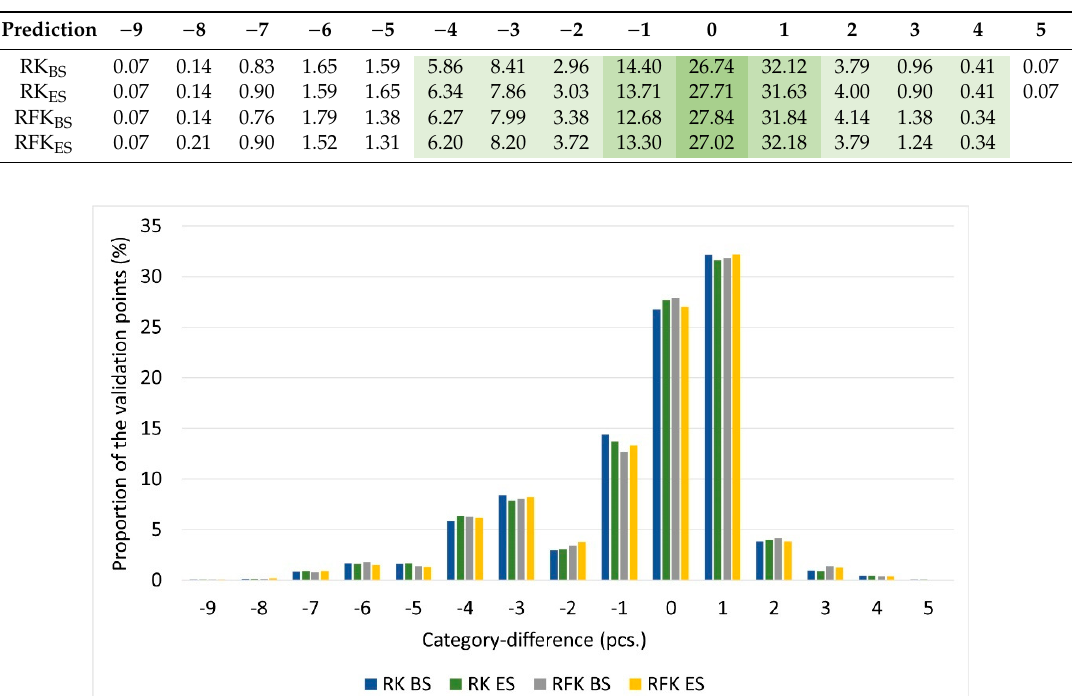
Figure 5. Category-difference between the independent validation dataset, and the categorized predicted values. Table 3. Di ff erence between the legacy map’s inundation frequency and the categorized inundation result maps expressed in